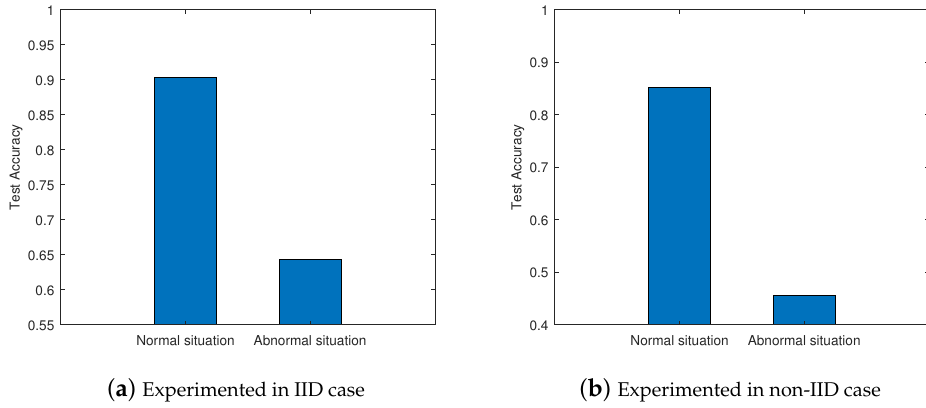
Figure 7. Accuracy comparison of FL for CIFAR10 data set in IID and non-IID cases with clients